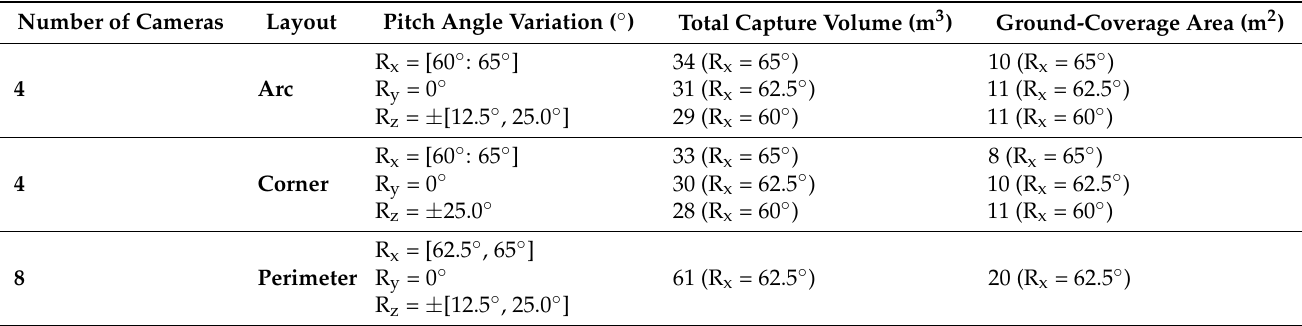
Table A1. Capture volume and ground-coverage area from the simulated camera layouts. R is the range of camera poses in the X, Y, and Z axis for each camera